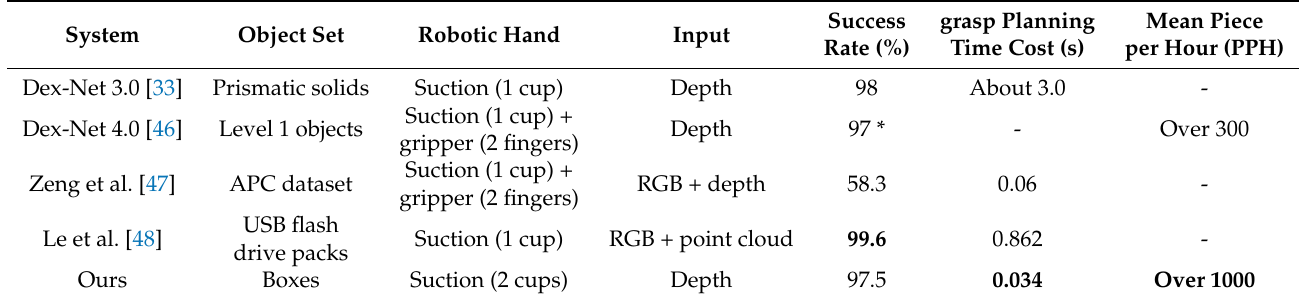
Figure 9. Example of one grasp attempt. ( a ) Grasp planning for textureless planar-faced objects by a DCNN model. Note that RGB color is only for visualization of the results. Text in grasp point labels indicates the grasp pattern class. First and second values beside the text are J distance and J inclination , respectively. ( b ) Vision-guided robot control. Yellow areas are target surfaces and blue points are surface centers. Table 3. Comparison of bin-picking system